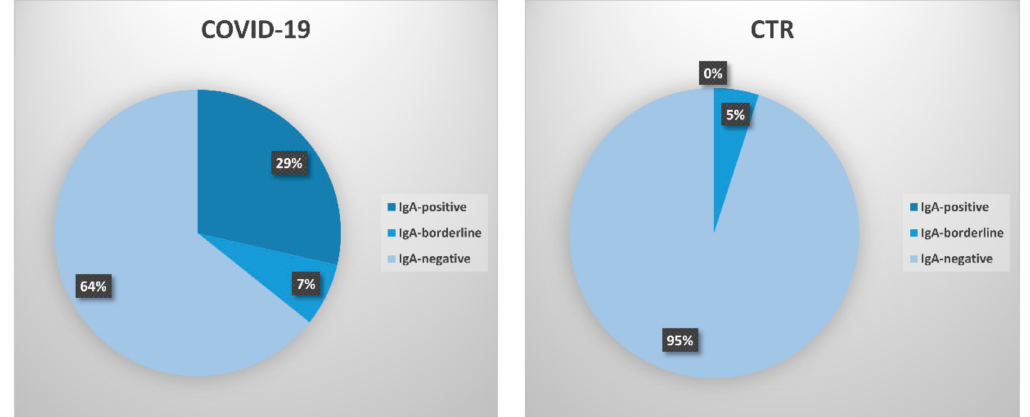
Figure 2. Percentage of positivity in COVID-19 patients and control subjects. Samples are subdivided based on their R value, as calculated following the manufacturer’s instructions. IgA-positive samples are defined as strongly positive samples with R ≥ 1.1; IgA-borderline samples are defined as samples which were weakly positive (0.8 ≤ R < 1.1); IgA-negative samples are defined as those having R <